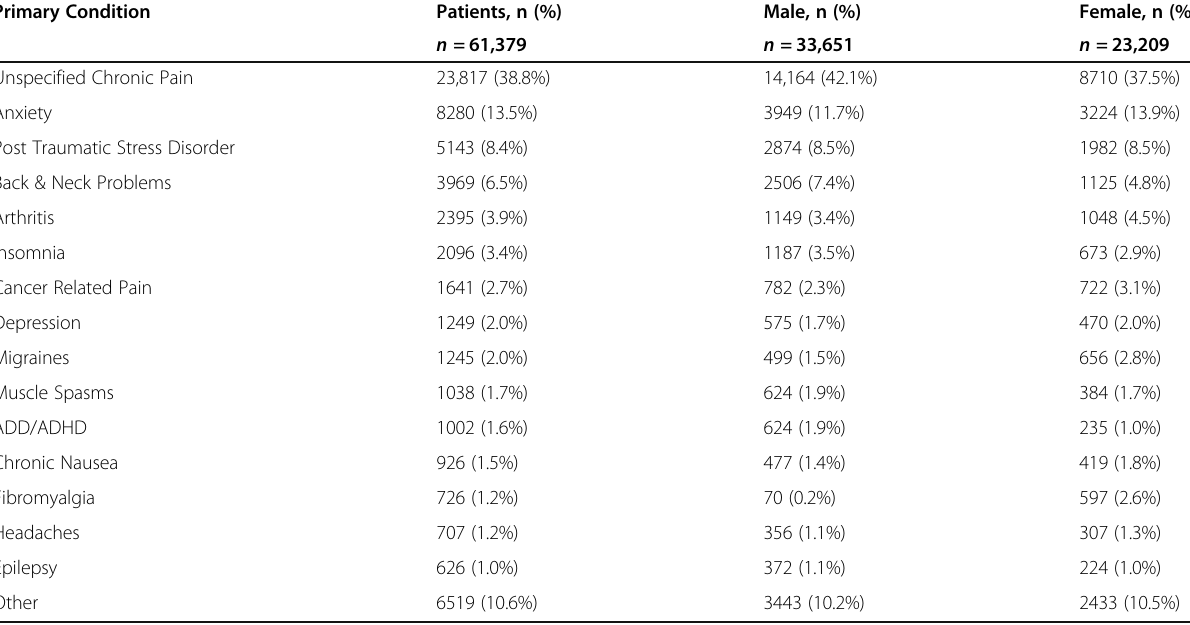
Table 5 Primary medical condition reported by 61,379 patients seeking medical cannabis certification, by gender Primary